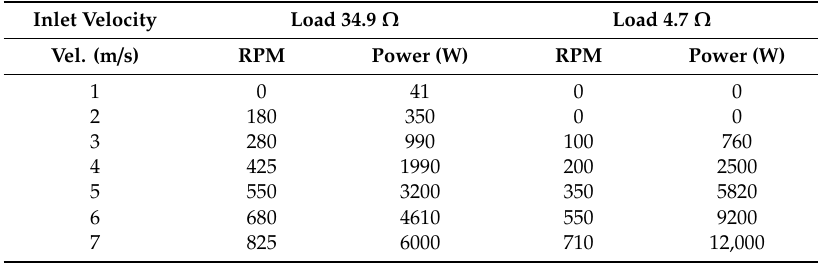
Table 5. Electrical load output at di ff erent